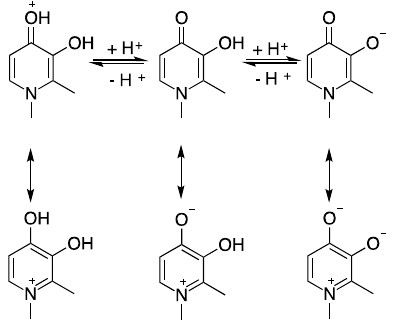
Figure 1. Deferiprone ( 1 ): Resonance structures at different protonation states [20].